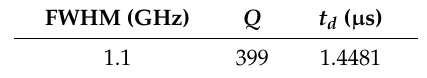
Figure 16. Transmittance as a function of applied force for 10, 30, 50 and 70 wires and a filter assembled with PTFE.